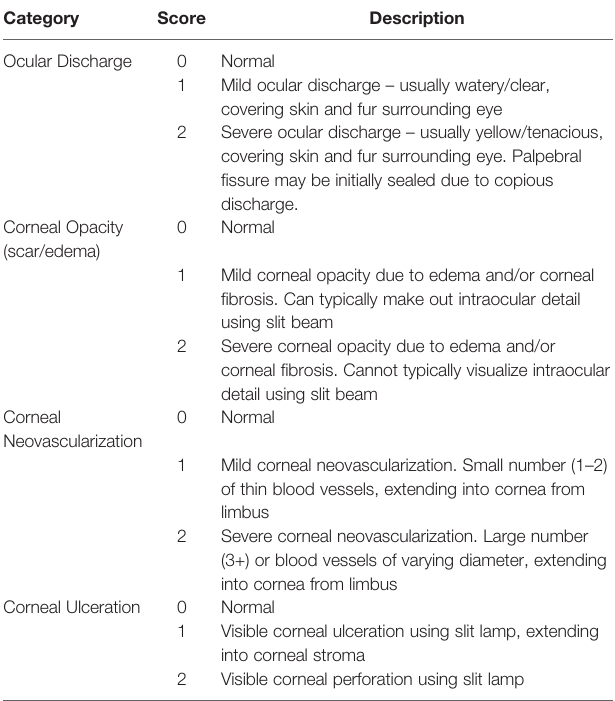
TABLE 1 | Ocular scoring system of